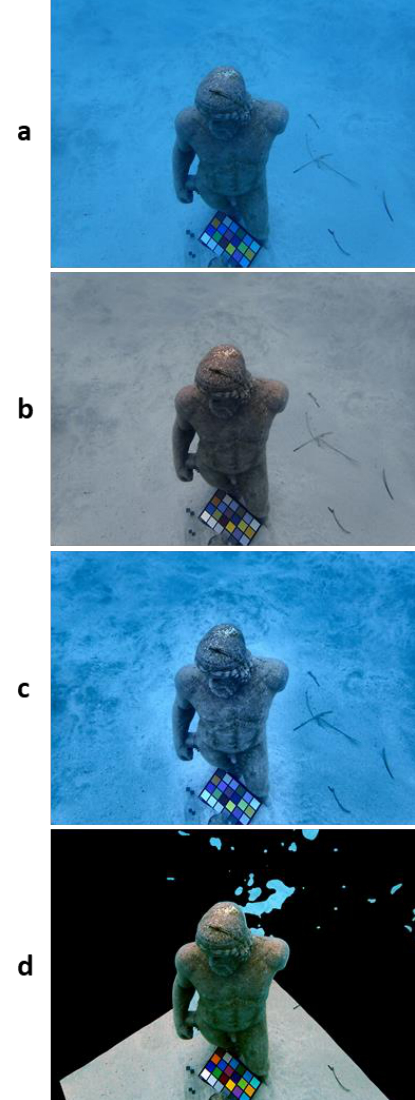
Figure 5. Correction results for Protaras Dataset: a) original image, b) Lab, c) CLAHE, d) proposed method (2 nd degree polynomial for the back scattering was used and 2 nd Figure 4. For Protaras dataset: from top to bottom is the colour value behaviour for Red, Green and Blue channels as the camera to object distance increases for the white and black colour patch respectively.